Question: How would you classify this visualization?
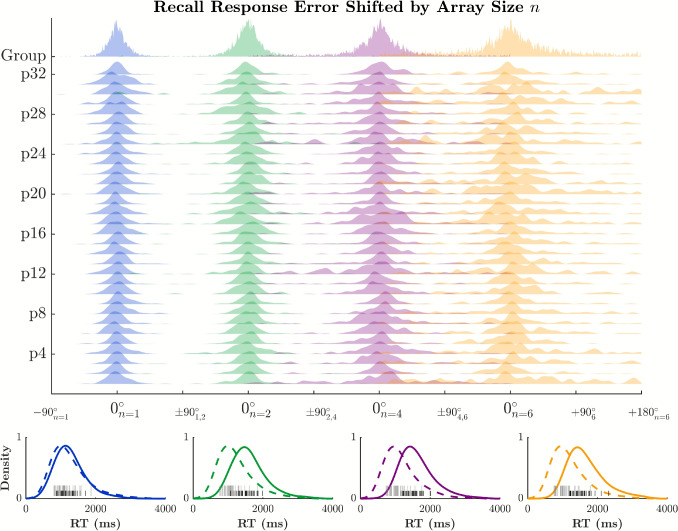
Answer: histogram